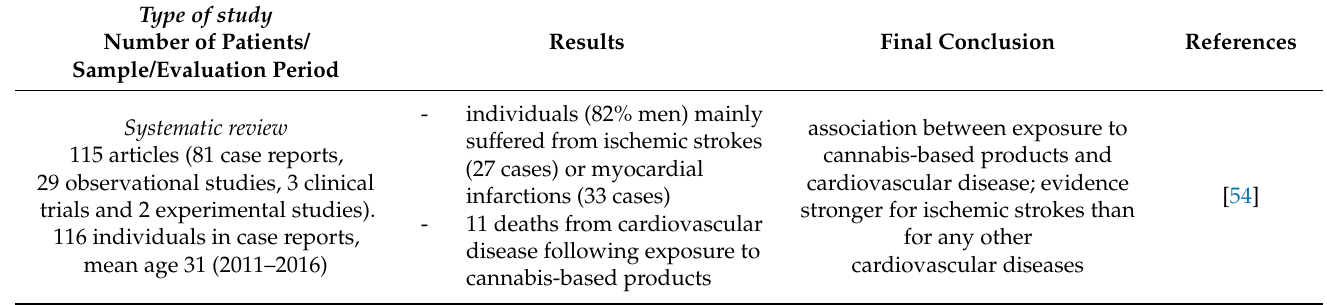
Table 1. Reviews from the past 5 years highlighting the potential impact of cannabis intake on the increase in risk of myocardial infarction and other severe cardiovascular